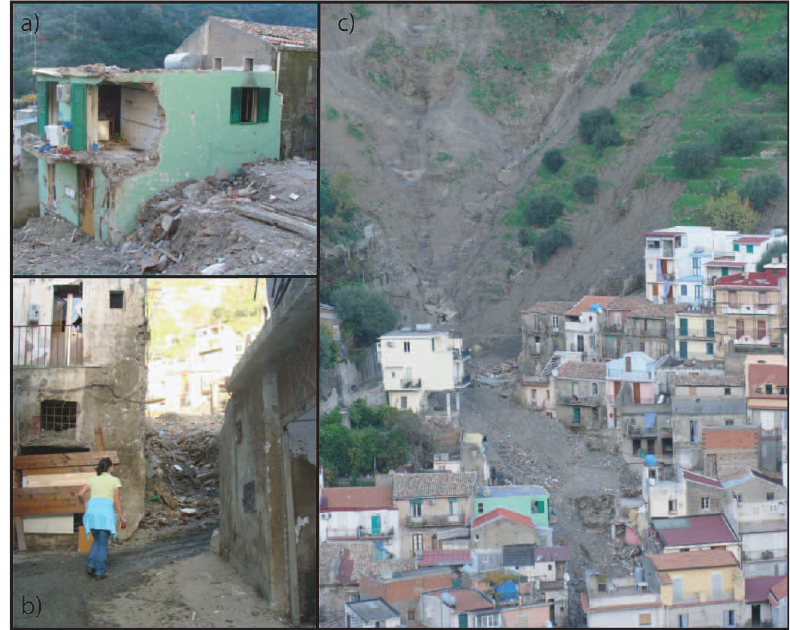
Fig. 4. Examples of the damages caused by one of the seven debris flows that occurred in Giampilieri. In (a) and (b) details of picture (c) are